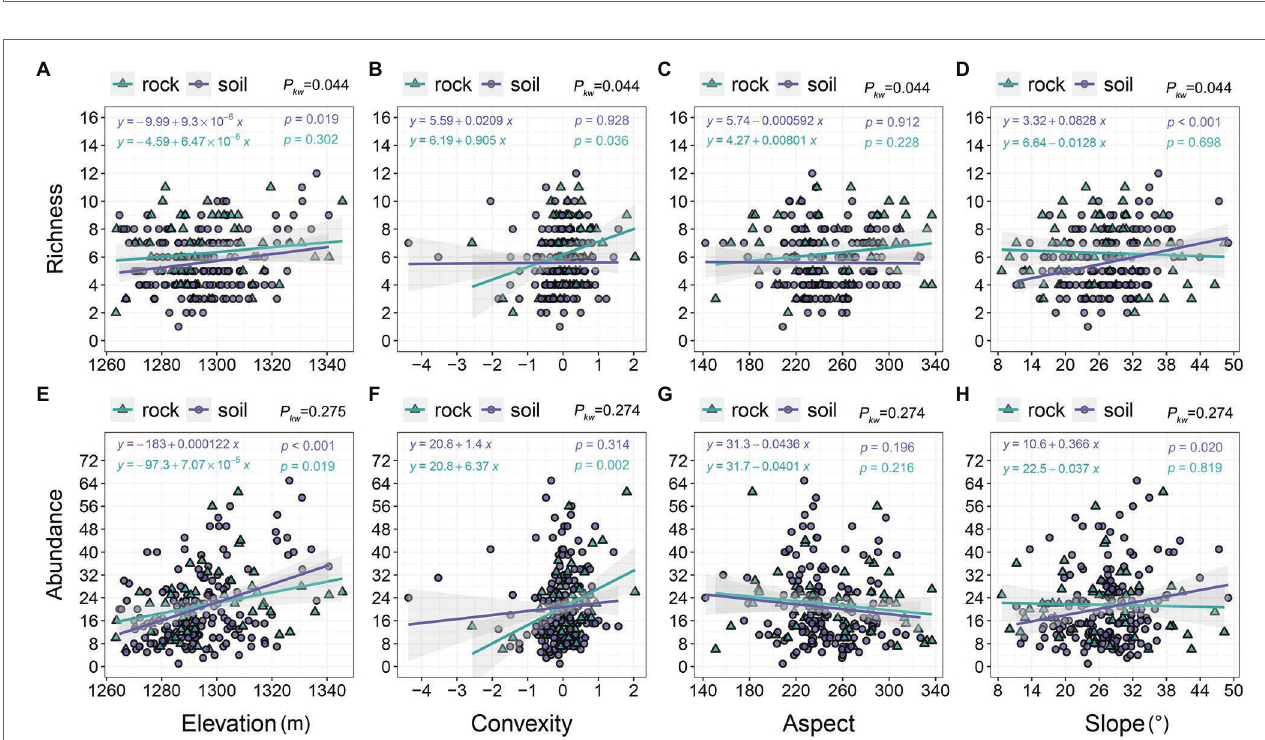
FIGURE 3 | The relationships of richness and abundance with topographic variables. p kw > 0.05, 0.01 < p kw < 0.05, and p kw < 0.01 represent non-significant, significant, and highly significant differences,